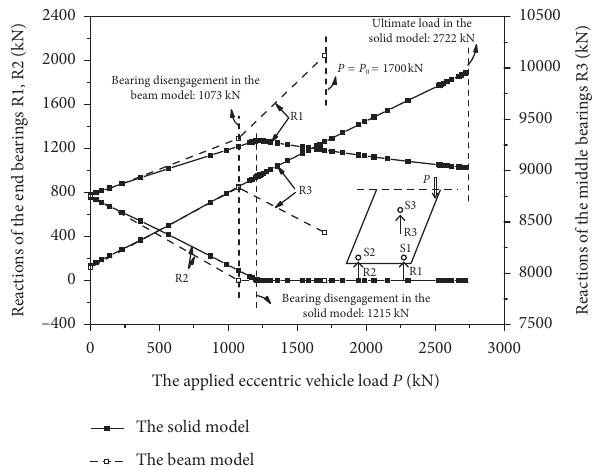
Figure 9: Applied load-vertical reactions relationships calculated from the beam and solid